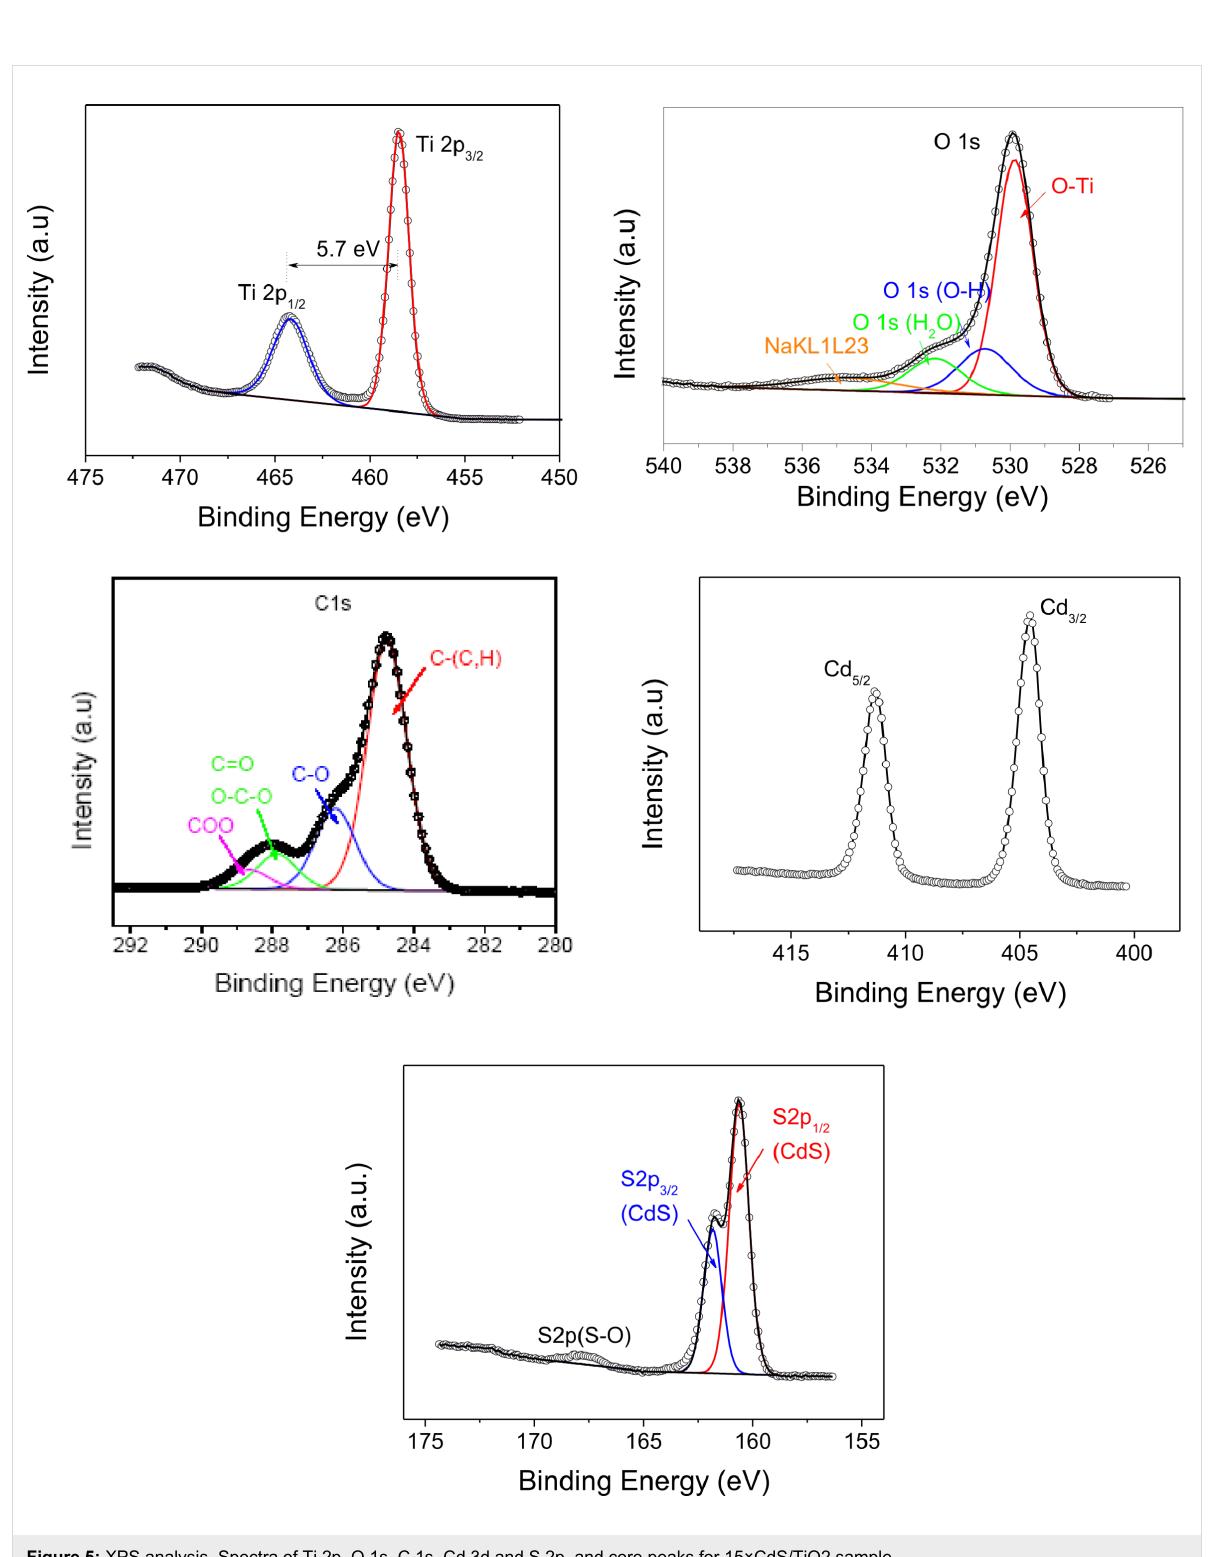
Figure 5: XPS analysis. Spectra of Ti 2p, O 1s, C 1s, Cd 3d and S 2p, and core peaks for 15×CdS/TiO2 sample.